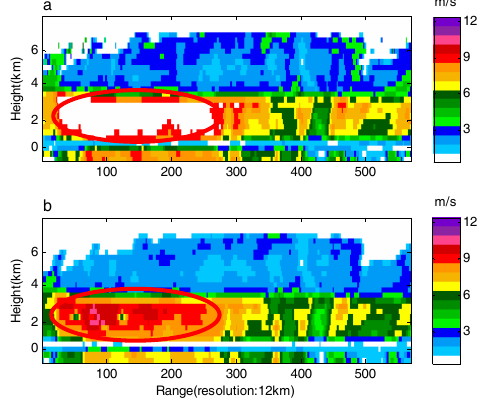
Figure 9. Comparison of the results of two velocity estimation methods. ( a ) Velocity echo with PPP method and the real velocity of the elliptical region is greater than 8.5 m/s; the white part of the ellipse indicates the ambiguous region; ( b ) velocity echo with FDPP method and the velocity in the ellipse close to the virtual velocity.